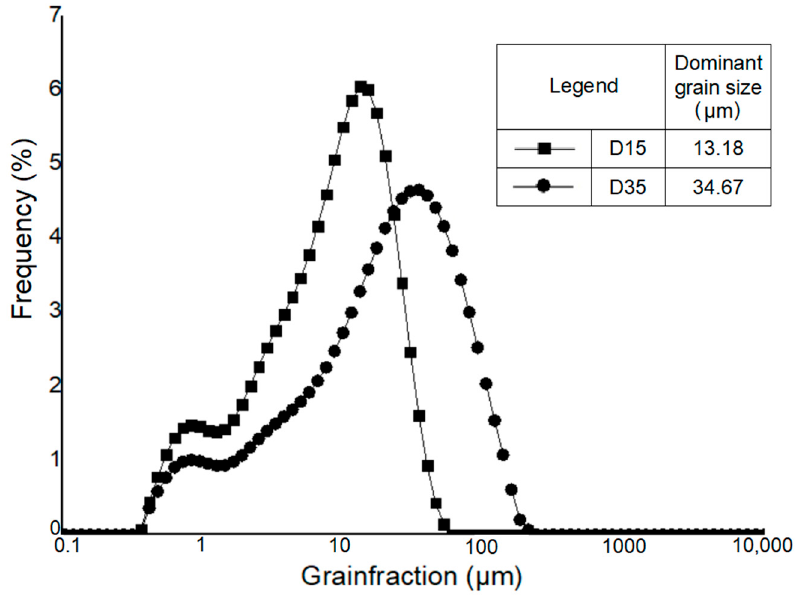
Figure 3. Granulometric curve of O ł drzychowice dolomite in different granulation [10].